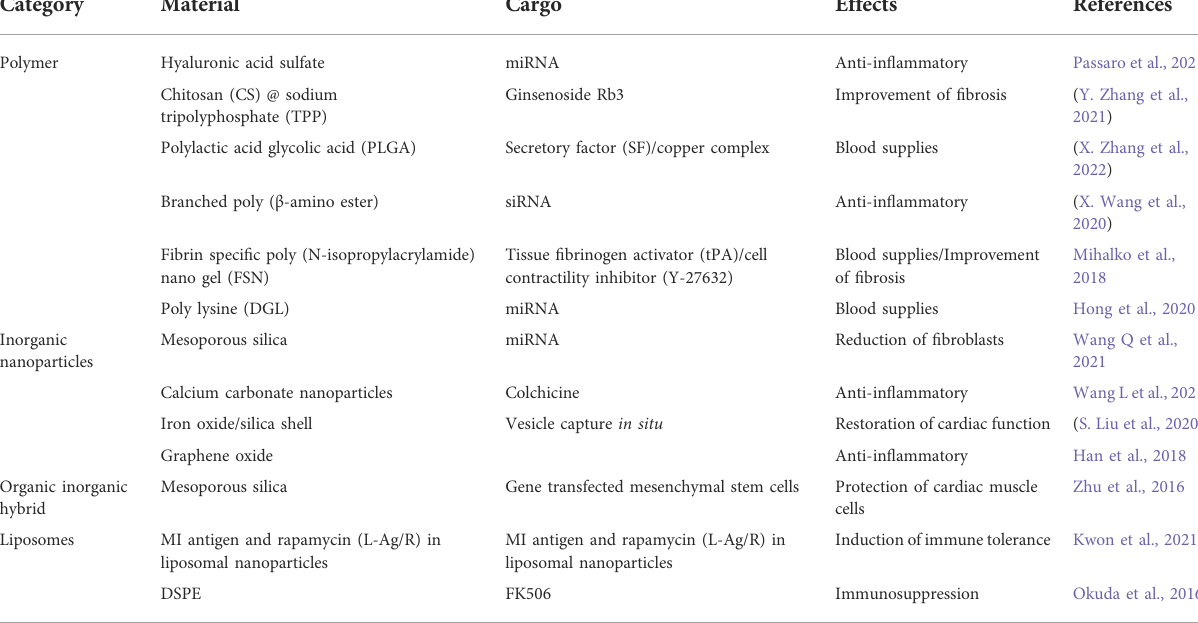
TABLE 3 Nanocarriers for myocardial fi